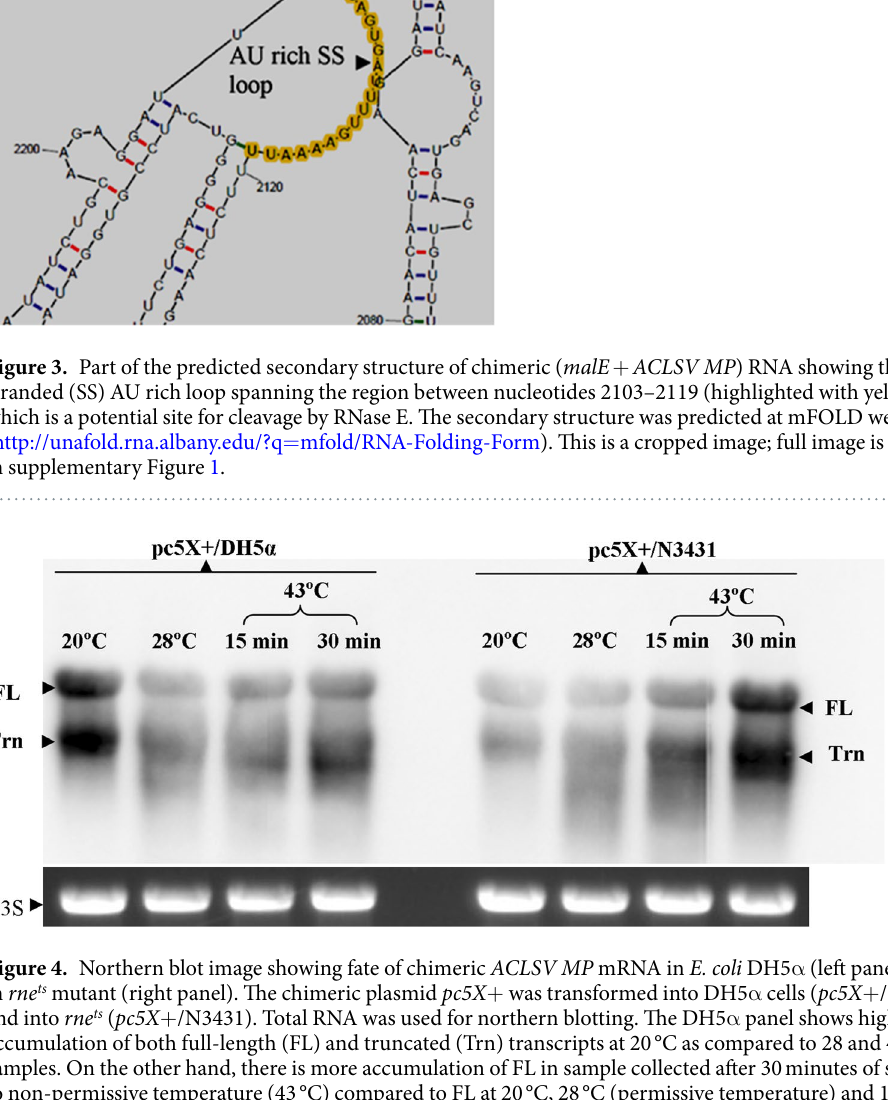
www.fruitfly.org/seq_tools/promoter.html. With a minimum promoter score kept at 0.8, seven sequences were identified which may have promoter activity (data not shown). The function of such a promoter sequence may